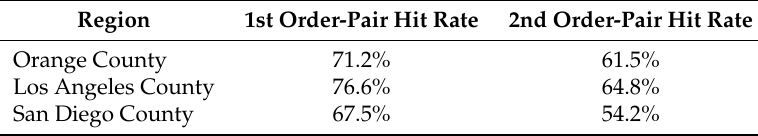
Table 4. Hit rates of first and second-order pairs of subjects in delineated